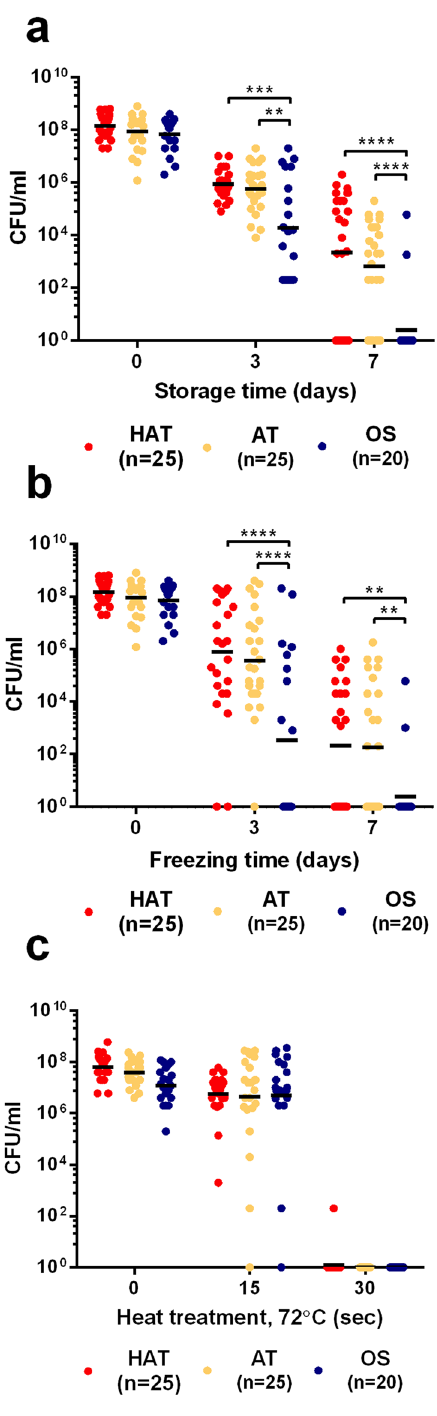
Figure 4. Tolerance to refrigeration ( a ), freezing ( b ), and heat ( c ) stresses in 70 strains of C . jejuni from retail chicken. The results are representative of three independent experiments. Similar results were observed in all three experiments. Solid black bars show the mean CFU. Statistical significance was determined using two-way